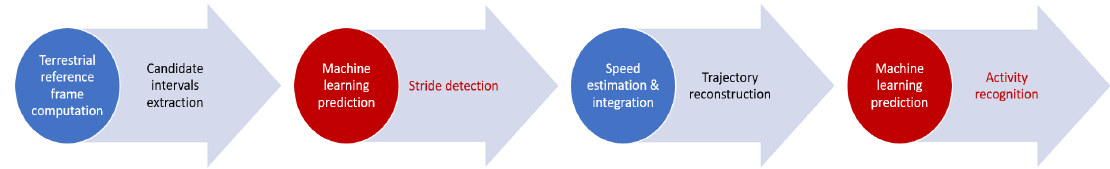
Figure 14. The four main algorithm stages with machine learning uses